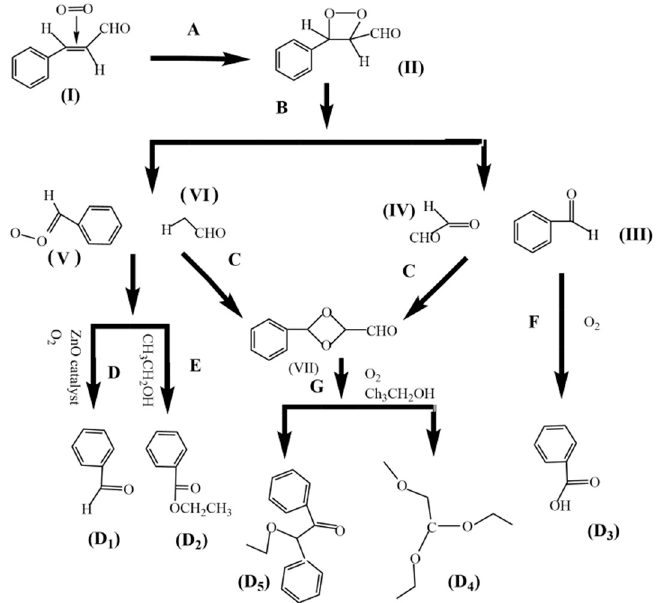
Figure 8. Suggested oxidation mechanism of cinnamaldehyde with O 2.